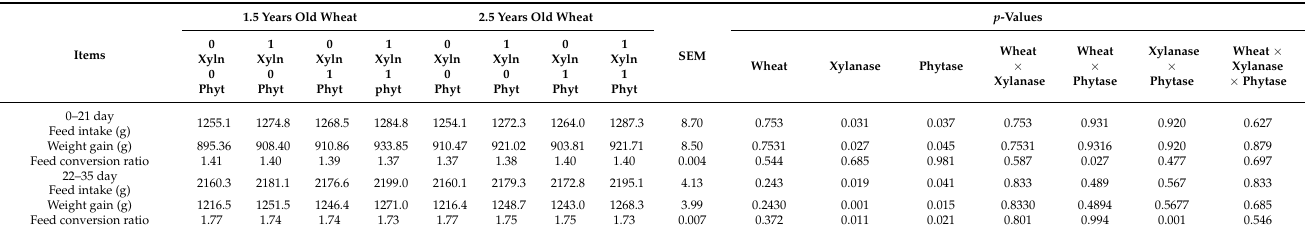
Table 3. Growth performance of broiler birds fed with stored wheat-based diet with and without the supplementation of xylanase and